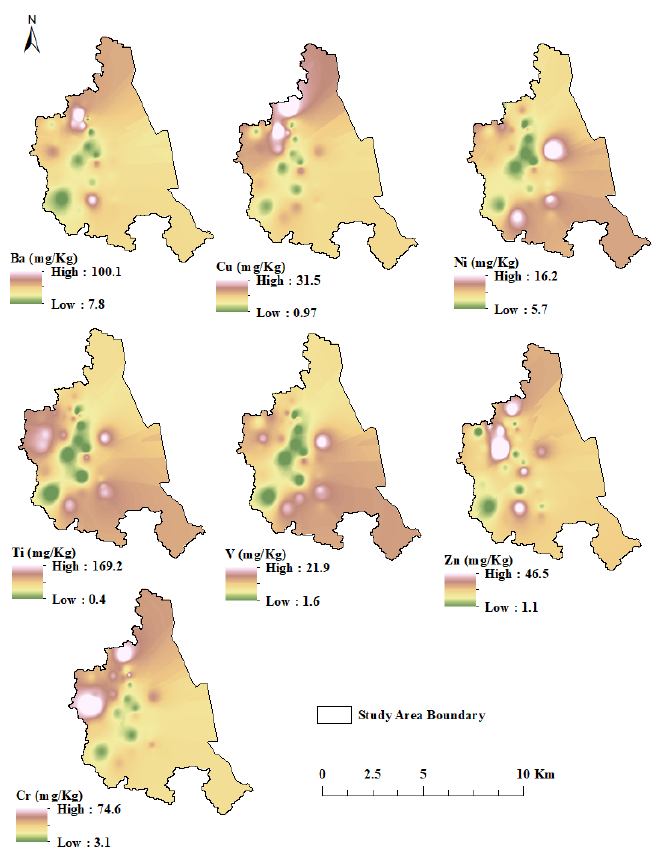
Figure 3. Spatial variability of input–output variables used for modeling.